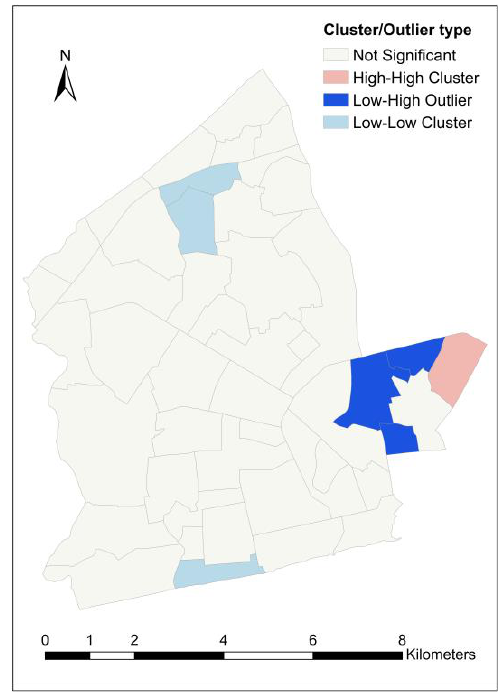
Figure 17. Cluster and outlier neighborhoods for ratio of load shedding exposure to population density.